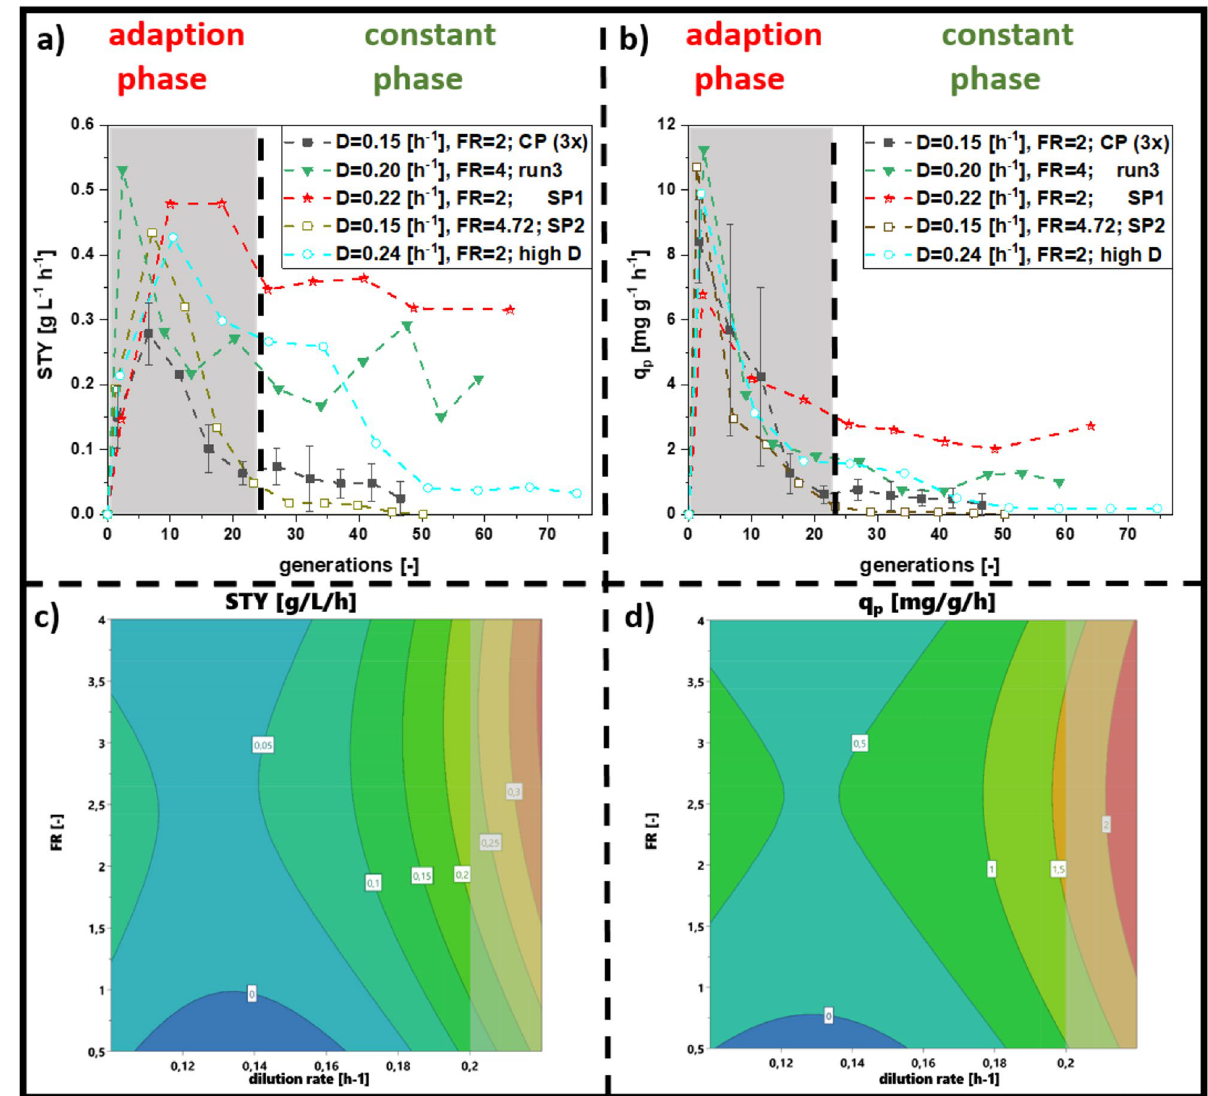
Figure 3. Comparing the optimum run of cascaded continuous cultivations derived from the DoE (design of experiment) (run 3) and the centerpoints, with star-point experiment 1 (D = 0.22/h with F in,gly = 6.6 g/h and F in,lac = 3.3 g/h), star-point experiment 2 (D = 0.15/h with F in,gly = 14.25 g/h and F in,lac = 3.3 g/h) and a further increase in dilution rate (D = 0.24/h with F in,gly = 6.6 g/h and F in,lac = 3.3 g/h) ( a ) STY (space–time-yield) ( b ) q p (specific productivity): Contour plots for ( c ) STY and ( d ) q p ( FR feed ratio, D dilution rate, SP star